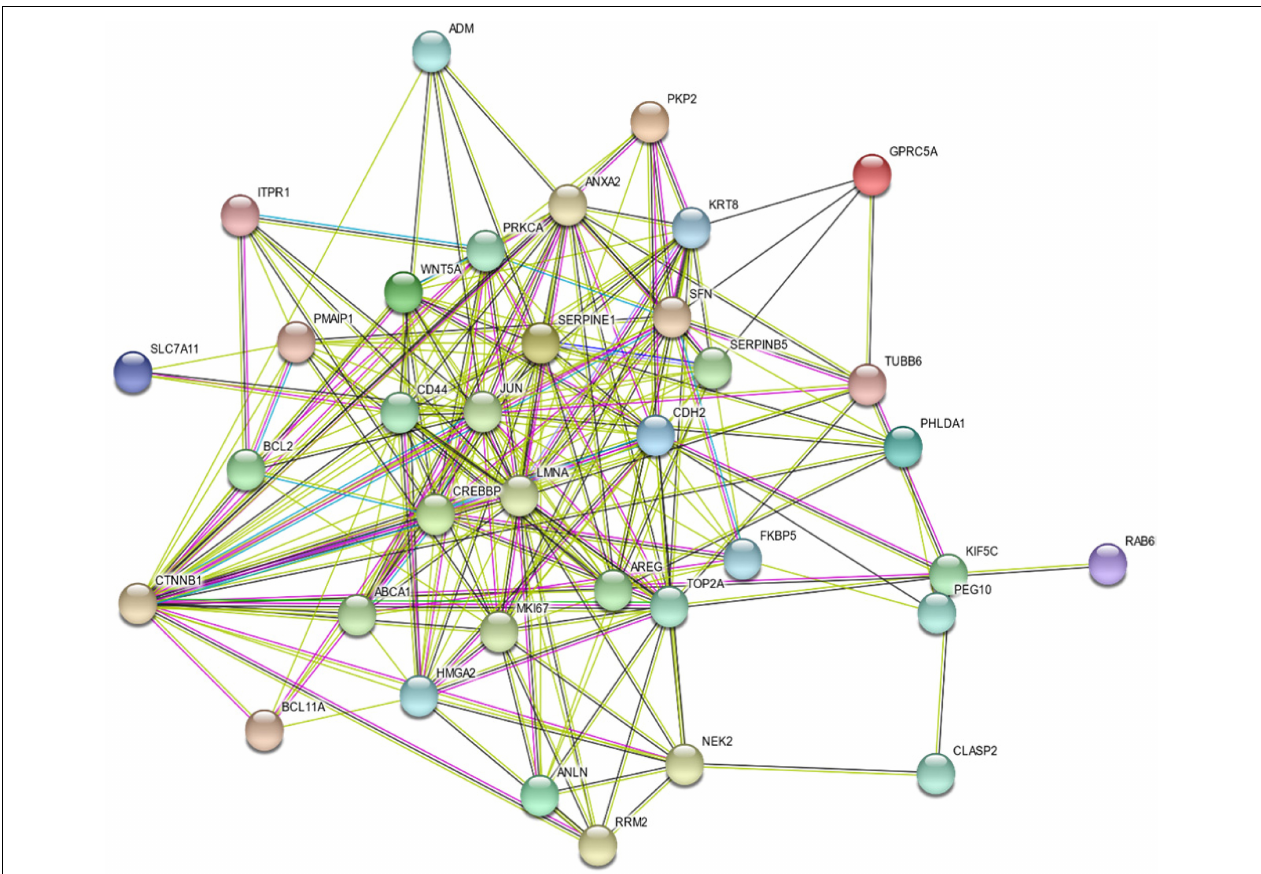
FIGURE 3 | Protein–Protein Interaction Between the Products of the Identified 35 Genes Using STRING v11: Protein–Protein Association Networks Tool.